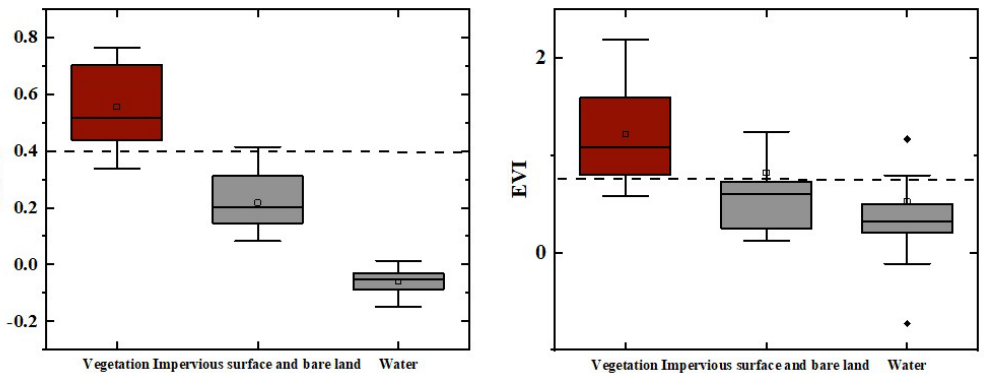
Figure 5. Box diagram of NDVI and EVI indices of typical surface features. Horizontal dashed lines indicate thresholds. The red boxes show the NDVI and EVI values of vegetation. The gray boxes show the NDVI and EVI values of other land use types.